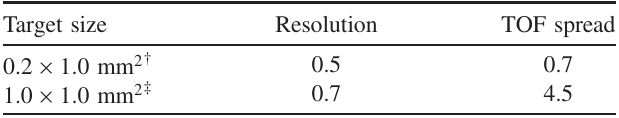
TABLE II. Summary of the resolution and the TOF spread for the HOPG-BSM. † : in the test stand, ‡ : in the MEBT1. (unit: degree).